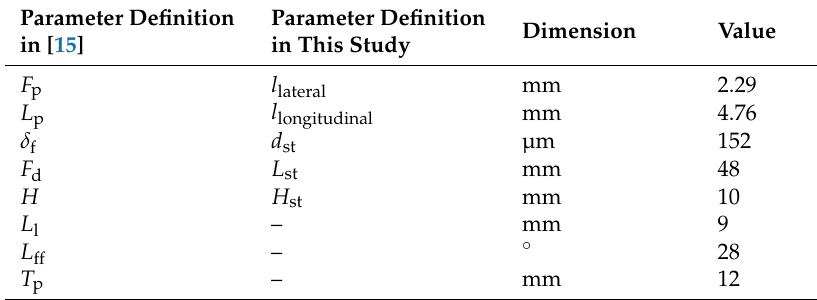
Figure A1. Definition of geometrical parameters for a multi-louvered fin heat exchanger [15]. Table A2. Geometrical parameters of the louvered fin heat exchanger with nomenclature from [15] and nomenclature used within this